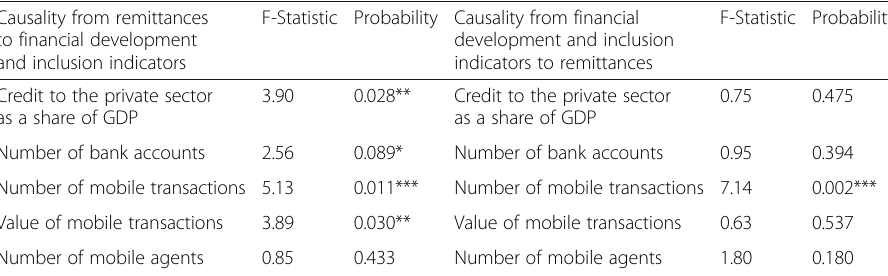
F-Statistic Probability Causality from financial development and